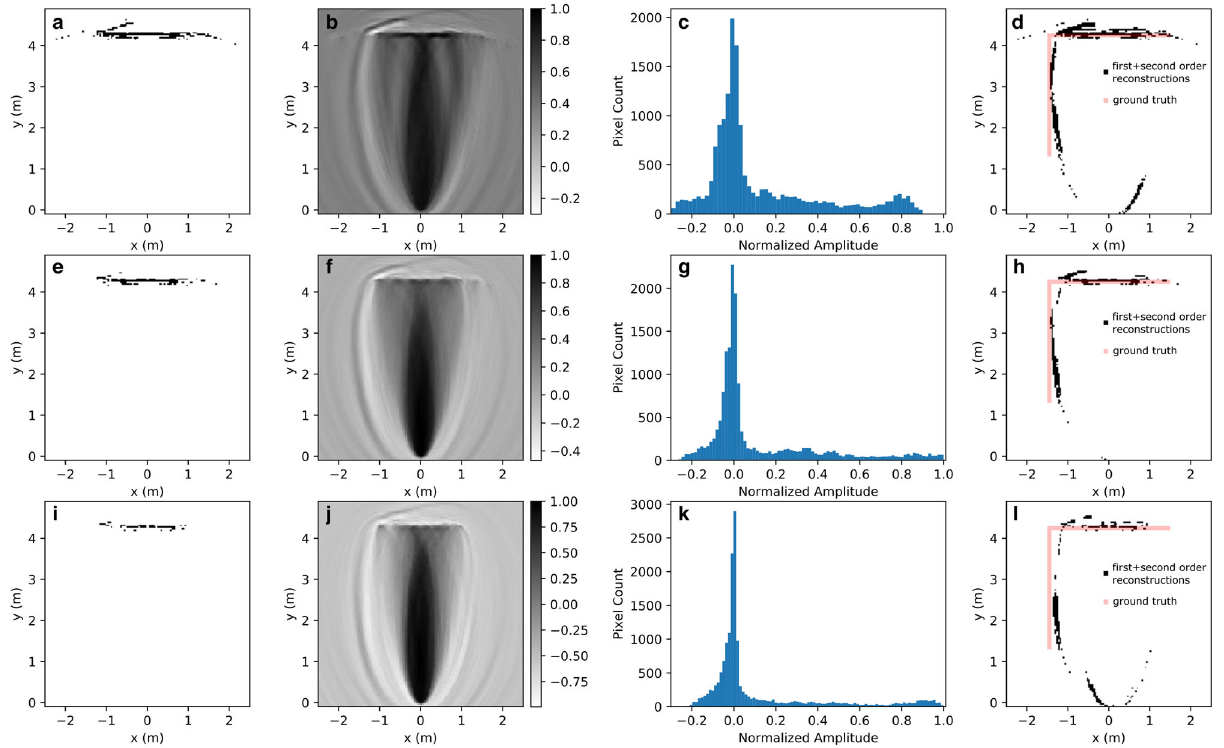
Fig. 6 Second-order reconstruction of the scene in Fig. 4a. Panel sets ( a , b , c , d ), ( e , f , g , h ), and ( i , j , k , l ) correspond to threshold fi lter levels of 4 σ , 5 σ , and 6 σ applied to the normalized image in Fig. 4b, respectively. Panels a , e , i correspond to the fi ltered fi rst-order image, the second-order result including gray scale bars ( b , f , j ) and corresponding intensity distribution ( c , g , k ), and the combined fi rst- and second-order masks ( d , h , l ) in black with the ground truth scene in